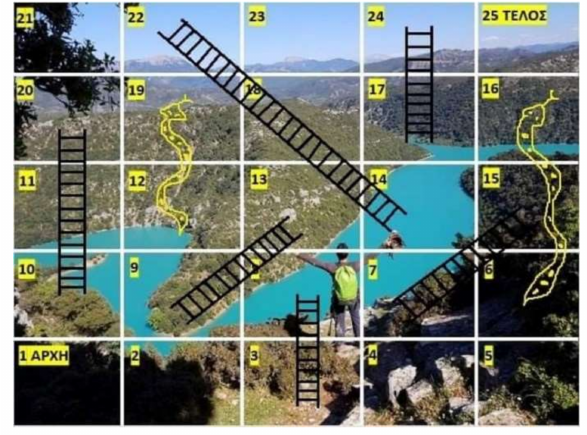
Figure 2. Snapshot from the board game